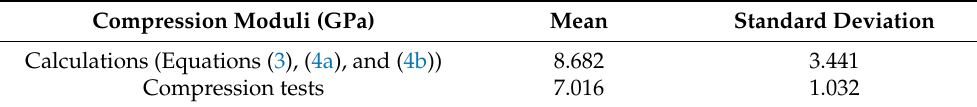
Table 4. Statistical overview of wood compression moduli from calculations and measurements.